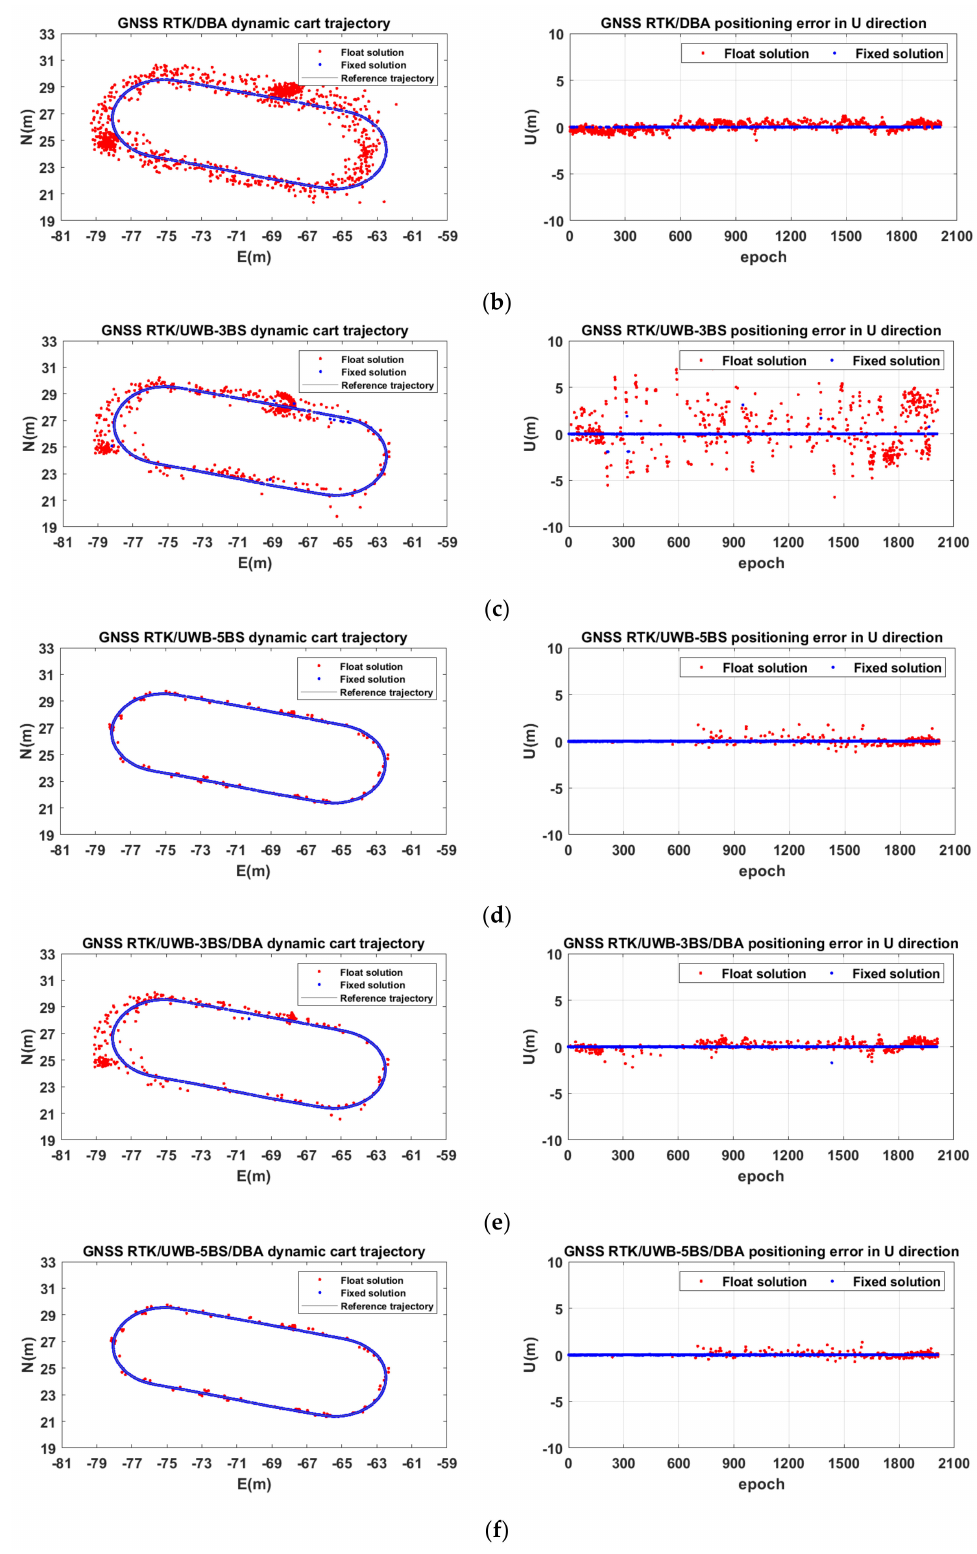
Figure 11. GNSS RTK/UWB/DBA fusion positioning model dynamic cart trajectory in the plane direction and positioning error in the U direction error at a 50 degree elevation mask an- gle: ( a ) GNSS RTK; ( b ) GNSS RTK/DBA; ( c ) GNSS RTK/UWB − 3BS; ( d ) GNSS RTK/UWB − 5BS; ( e ) GNSS RTK/UWB − 3BS/DBA; ( f ) GNSS RTK/UWB −